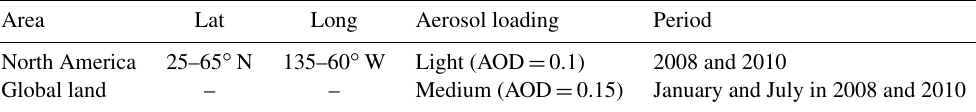
Table 1. Information of two case studies. Here, the AOD for the cases is obtained by averaging the corresponding AERONET measurements. Area Lat Long Aerosol